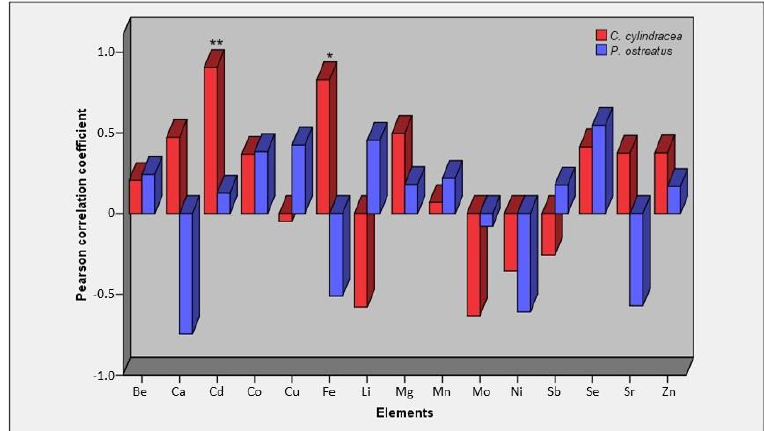
Figure 2. Values of Pearson's r correlation coefficient for elements content in C. cylindracea and P. ostreatus mushrooms vs. their concentration in cultivation substrates. Levels of statistical significance are depicted as follows: p < 0.05 (*) and p < 0.01 (**).